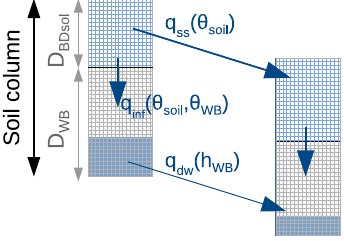
Figure 5. SSF and SSF-DWF models of flow generation by the satu- ration of the upper part of soil column and activation of preferential paths ( q ss ), with support flow at depth ( q dw ) and water exchanges from the upper layer to the lower one according to both soil water content, represented by q inf (θ soil , θ WB ) . See Eqs. (2), (3) and (4) for the definition of the